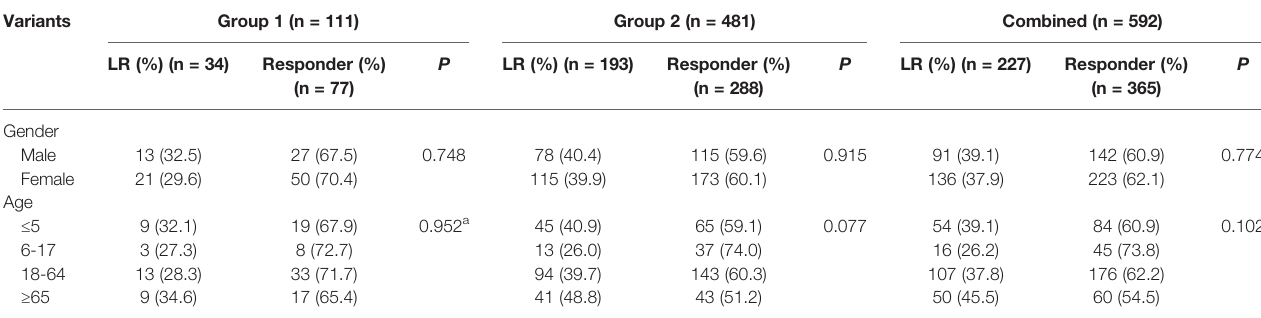
TABLE 1 | Characteristics of subjects in three